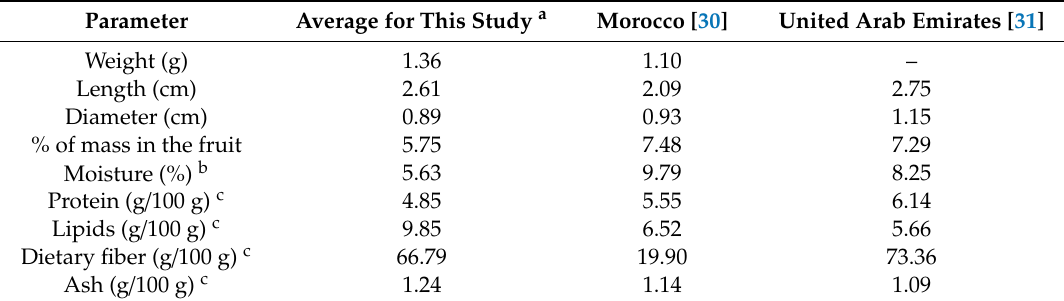
Table 8. Comparative analysis of the physical characteristics and proximal composition of the average obtained from the four treatments used in this study, against studies developed in the Medjool seeds in Morocco and the United Arab